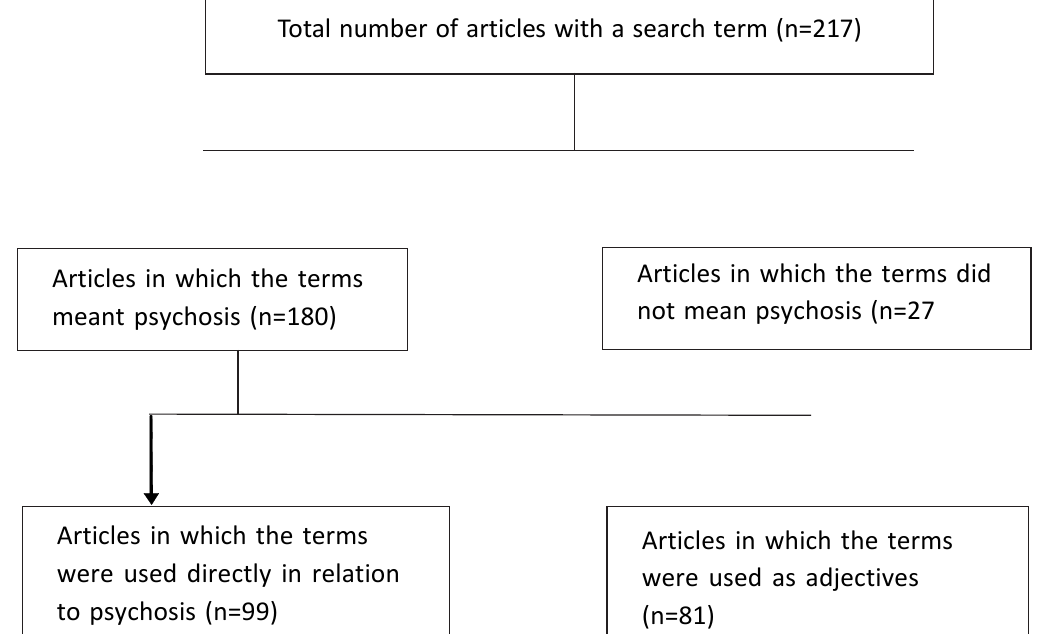
Figure 1. Flow diagram showing article selection process used in this